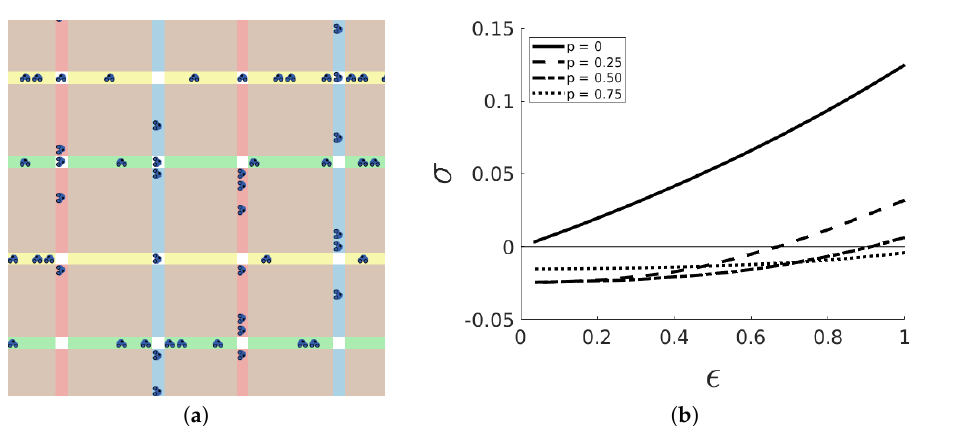
Figure 6. ( a ) A “square” city, where streets are alternating one-way ( p = 0). ( b ) Average intransitiveness index σ vs absorbency (cid:101) for a “square” city, where p denotes the probability of having two-way streets instead of alternating one-way (city with 4 × 4 streets, average over 1000 simulations; the results are largely independent on the city